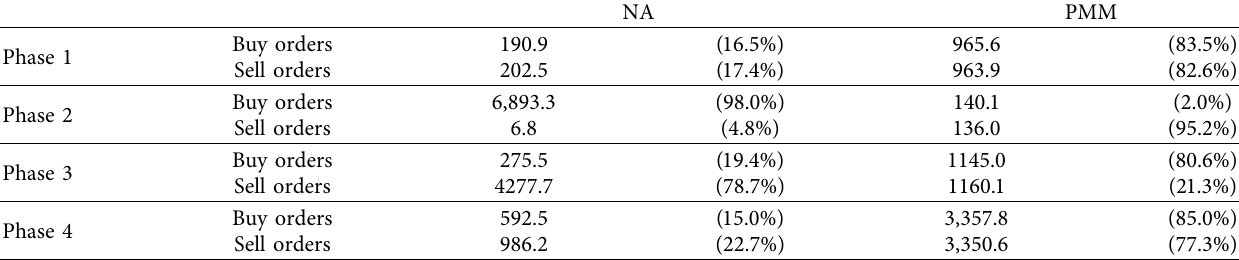
Table 3: Numbers and proportions of NA’s and PMM’s orders in the order book that matched a new order.